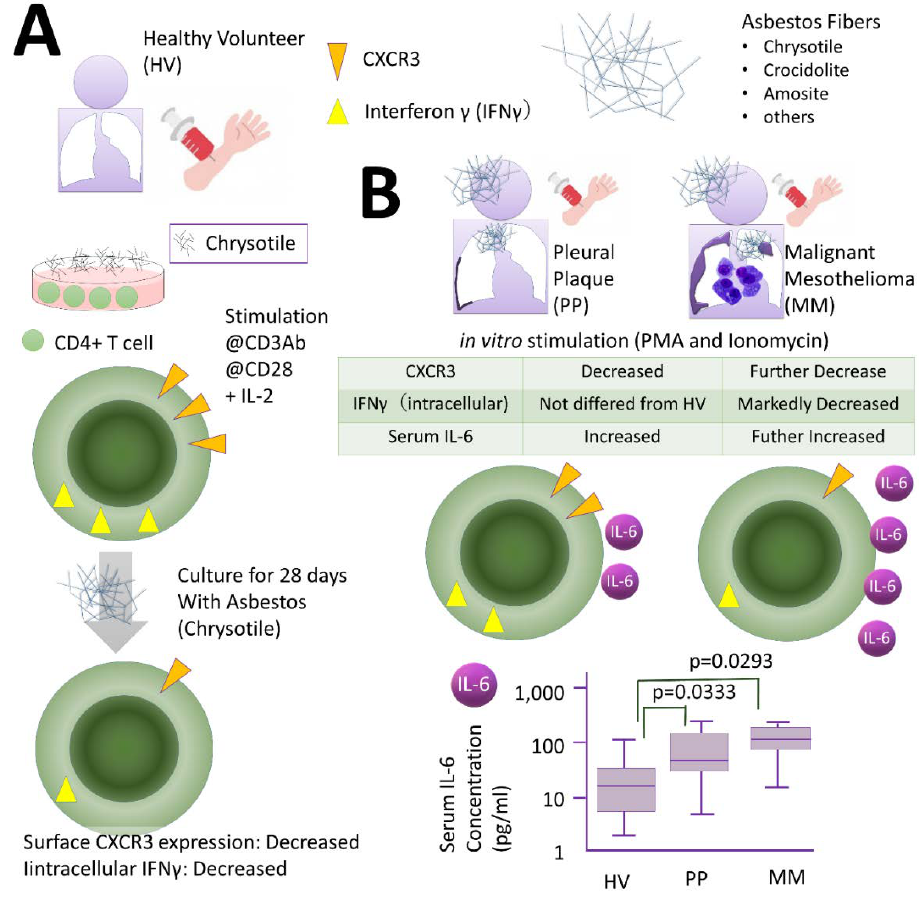
Figure 2. Effect of asbestos fibers on Th cells. ( A ) CD4 + T lymphocytes were isolated from HV peripheral blood and treated with interleukin (IL)-2 together with anti-CD3 and anti-CD28 antibodies for 4 weeks to induce clonal expansion. Expression levels of CXC chemokine receptor (CXCR) 3 on the cell membrane surface changed markedly. Intracellular IFN- γ expression levels were also reduced. ( B ) CD4 + cells were collected from the peripheral blood of individuals with PP or MM who were actually exposed in vivo, and these cells were stimulated overnight with PMA and ionomycin in an effort to observe changes in CXCR3 on the membrane surface and intracellular IFN- γ . CXCR3 levels diminished in cells derived from HV, and the PP and MM groups. However, although IFN- γ levels were lower in the MM group, they did not differ between HV and the PP group. When several representative cytokines related to HV, PP, and MM were measured, IL-6 levels in cells derived from the PP and MM groups were higher than those of HV. There was no statistically significant difference between the PP and MM groups, although the MM group tended to be slightly higher.